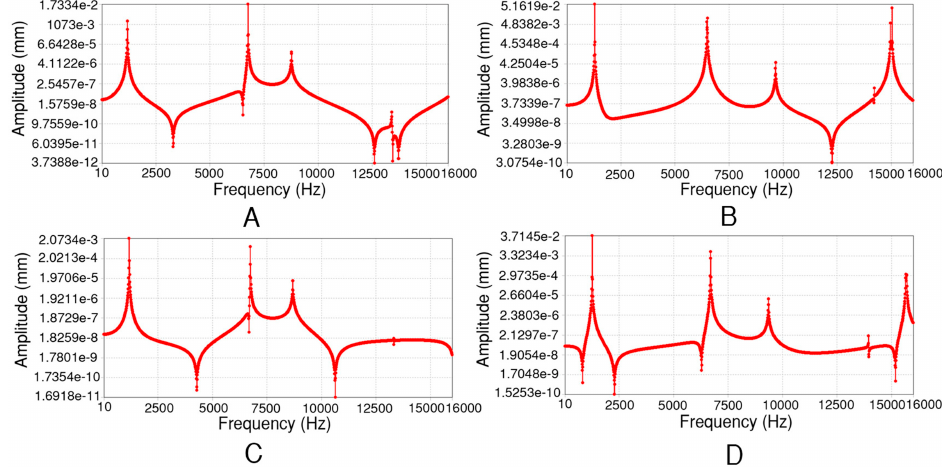
Figure 11. Amplitude response curve of ( A – D )-type end milling cutter in y direction.